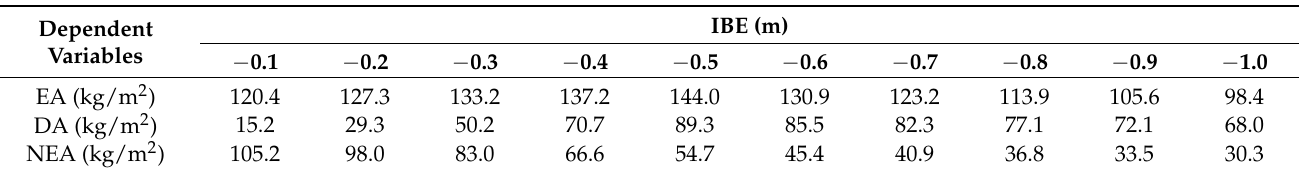
Table 4. Erosion amount (EA), deposition amount (DA), and net erosion amount (NEA) per unit area for different IBEs, after 100